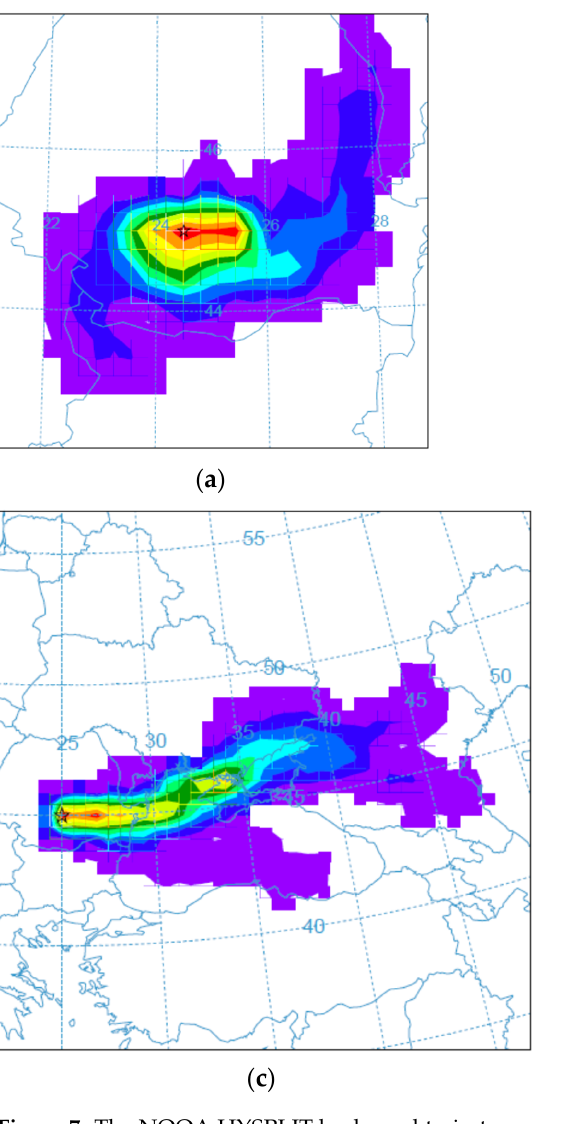
( a ) 10 October to 7 October 2019; ( b ) 16 November to 13 November 2019; ( c ) 22 November to 19 November; ( d ) 29 November